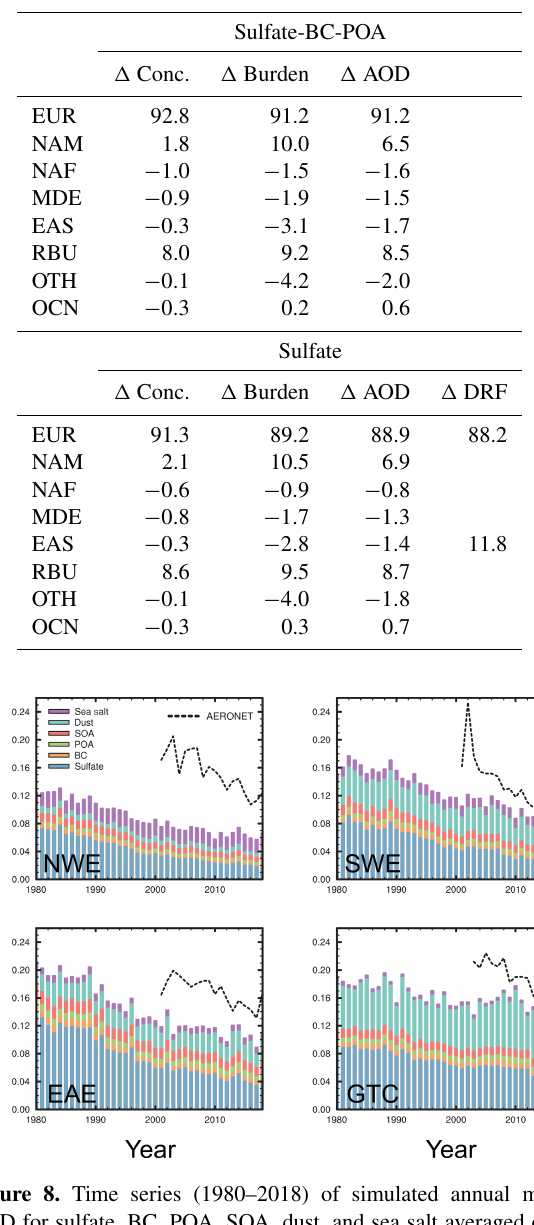
Table 2. Relative contributions (in percent) of emissions from major source regions to the changes in near-surface concentrations, col-